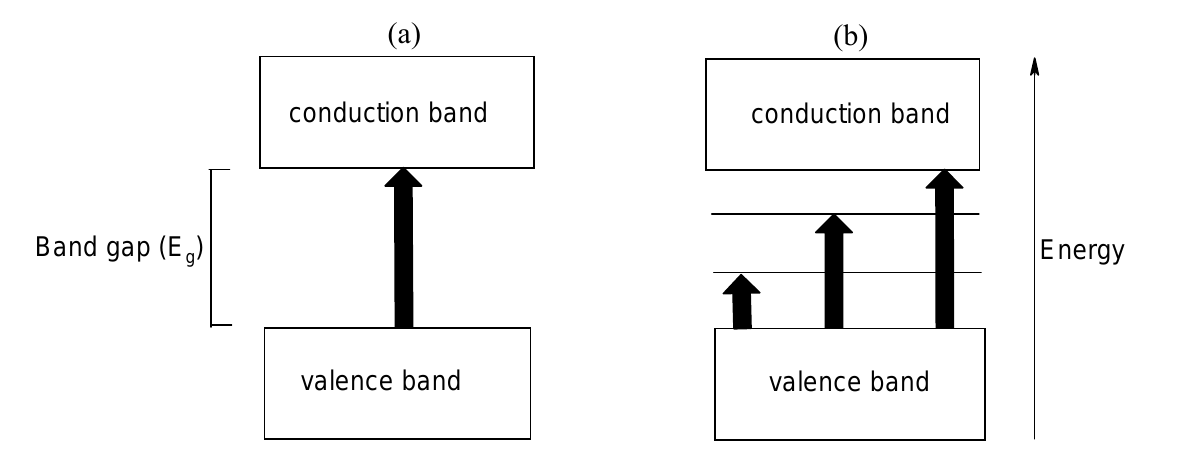
Figure 13. Effect of doping on the band gap and energy in conducting polymers. (a) an undoped and (b) an oxidatively doped (bipolaron) conducting polymer.